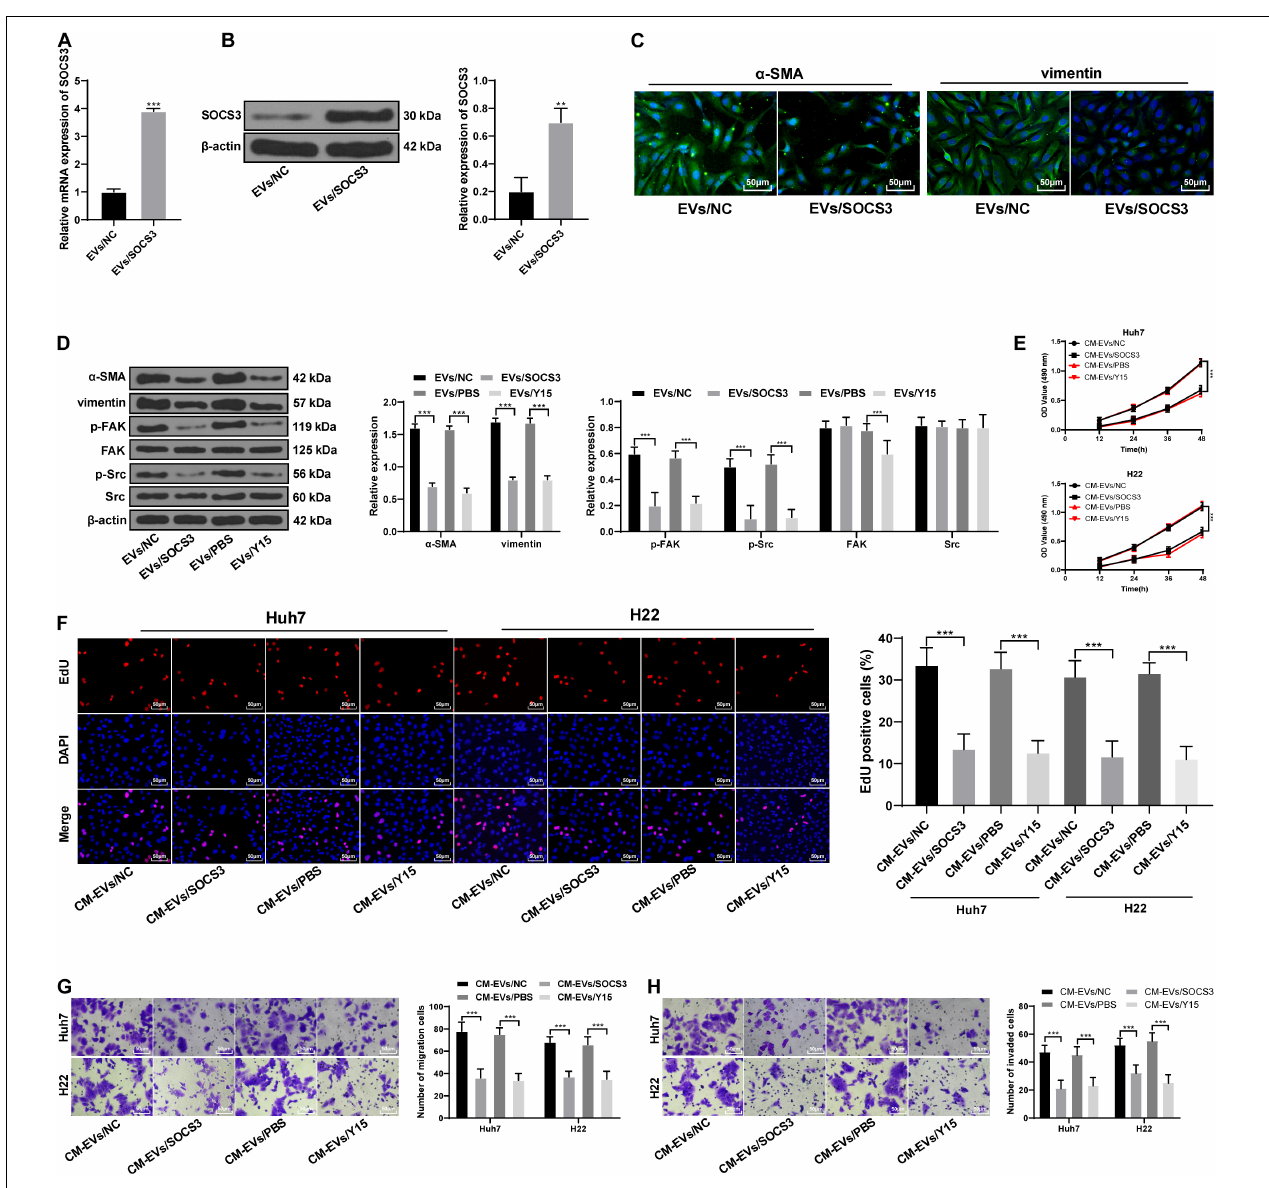
FIGURE 7 | SOCS3 overexpression inhibited the FAK/Src pathway and reversed the promotion of invasion induced by BMSCs that differentiated into fibroblasts after the action of EVs. (A,B) SOCS3 levels were detected by RT-qPCR and Western blot analysis to verify the transfection efficiency. (C) α -SMA and vimentin in BMSCs were detected by immunofluorescence. (D) levels of α -SMA, vimentin and the FAK/Src pathway-related proteins in hepatoma cells were detected by Western blot analysis. (E) MTT assay was used to detect the proliferation ability of Huh7 and H22 cells at different time points. (F) EdU assay was used to detect the proliferation ability of Huh7 and H22 cells. (G,H) Transwell assay was used to detect the invasion and migration ability of Huh7 and H22 cells. ** p < 0.01, *** p < 0.001. Data in panels (A,B) were analyzed by the t test, and data in panels (D–H) were analyzed by one-way ANOVA, followed by Tukey’s multiple comparison test. Replicates =